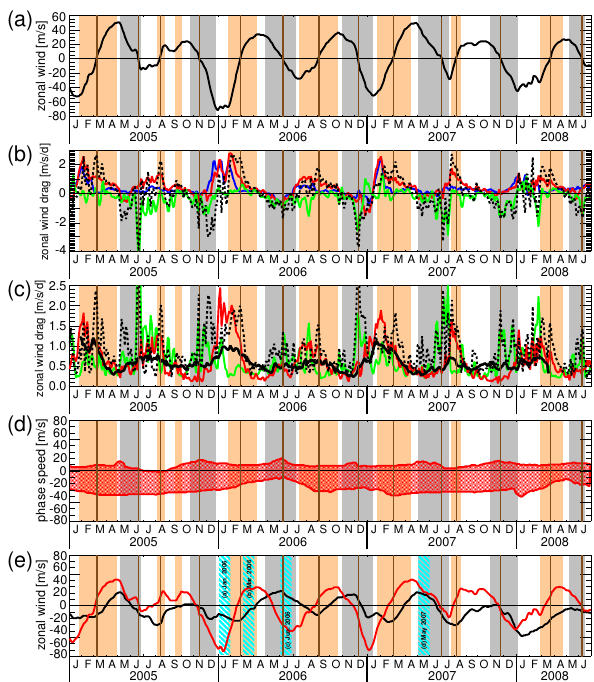
Figure 3. Time series at 47km (about the center altitude of the SAO) for the period January 2005 until June 2008. All parame- ters are averages over the latitude band 10 ◦ S–10 ◦ N. (a) The zonal- average zonal wind from ERA-Interim in ms − 1 and (b) the ERA- Interim zonal momentum budget terms: ∂u/∂t (black dashed), 0.5 times the sum of meridional and vertical advection terms (blue), 0.5 times missing drag (red), and planetary wave drag for zonal wave numbers 1–20 (green). (c) Comparison of observed HIRDLS grav- ity wave drag at 46km (black) and absolute values of several ERA- Interim terms at 47km averaged vertically over 10km: ∂u/∂t (black dashed), planetary wave drag (green), and 0.5 times missing drag (red). (d) Range of ground-based phase speeds (red shaded) that are filtered out by the QBO in the altitude range 18–40km. (e) ERA- Interim zonal wind at the altitude levels z 1 = 41km (black) and z 2 = 51km (red). Months of four characteristic background wind situations are indicated by blue hatched bands. In all panels peri- ods of strong westward (eastward) wind shear are indicated by gray (orange) shading. Times when the zonal wind at 47km is zero are marked by brown vertical